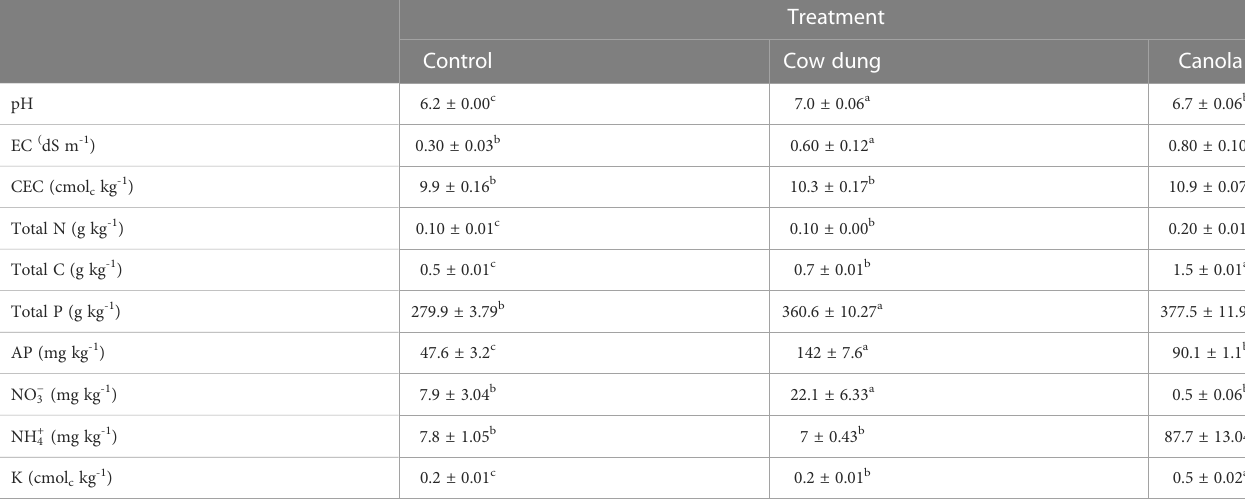
TABLE 1 Effects of soil amendment with cow dung and canola on soil chemical properties of ginseng soil with replanting problem a